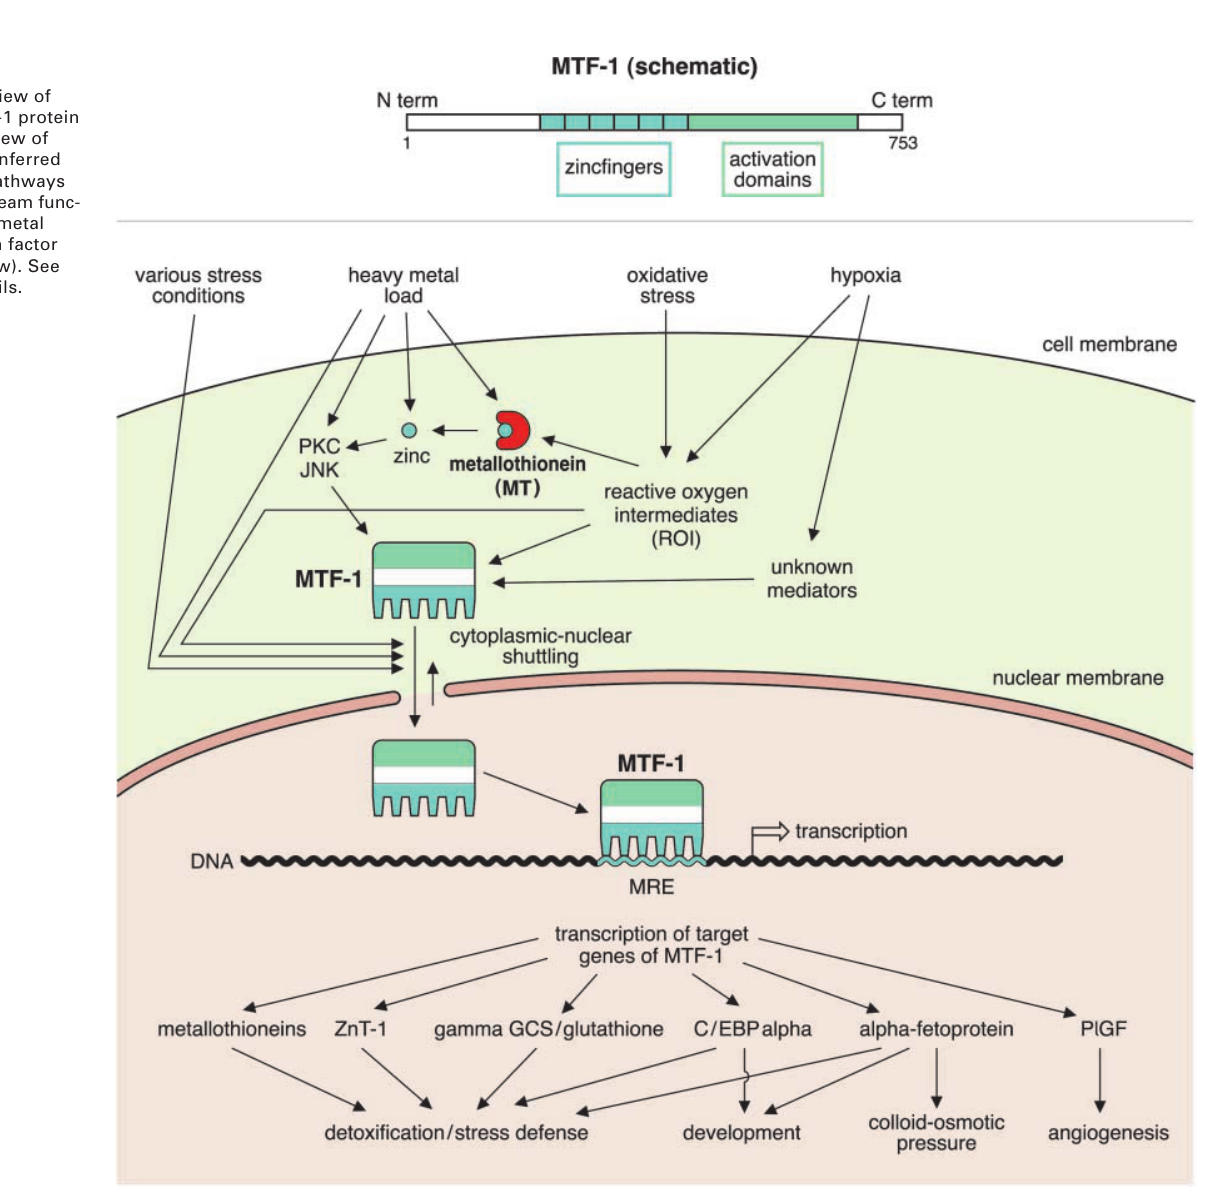
A Figure 1 Histology of wild-type (A) and MTF-1 knockout (B) embryos showing the disrupted liver phenotype in MTF-1 -/- embryos. Haematoxylin and eosin-stained sagittal liver sections of embryos at stage E13.5. MTF-1 -/- (B) embryonic livers show enlarged, congested sinusoids and dissociation of the epithelial compart- ment. The remaining hepatocytes are clustered to form contiguous cell patches (arrows).